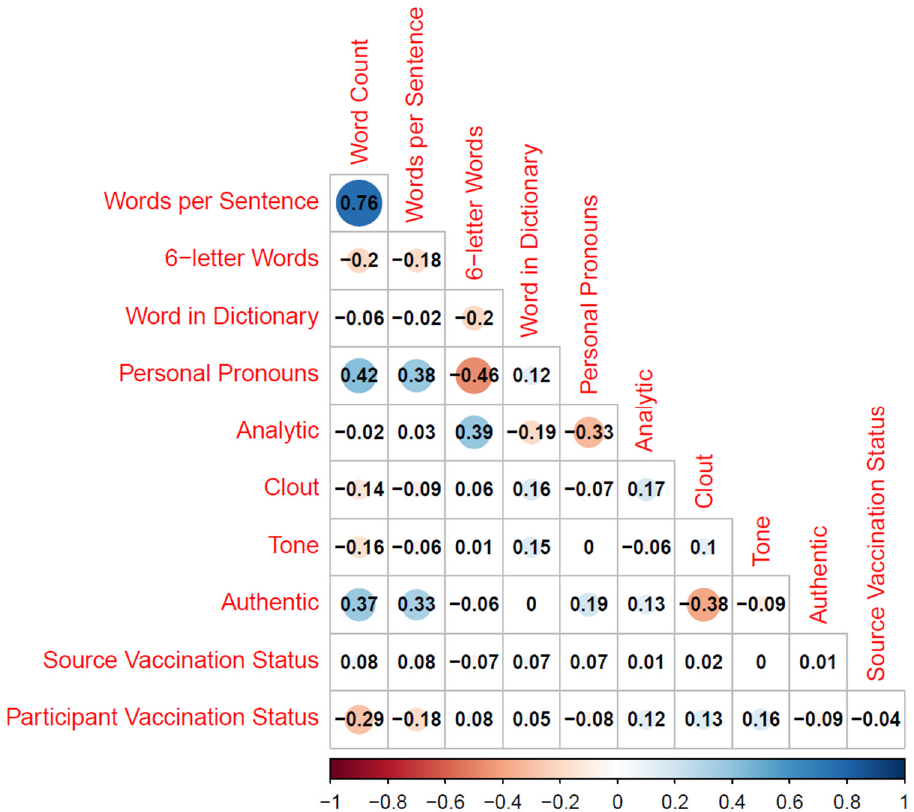
Figure 1. Spearman correlations between linguistic summary scores, source vaccination status and